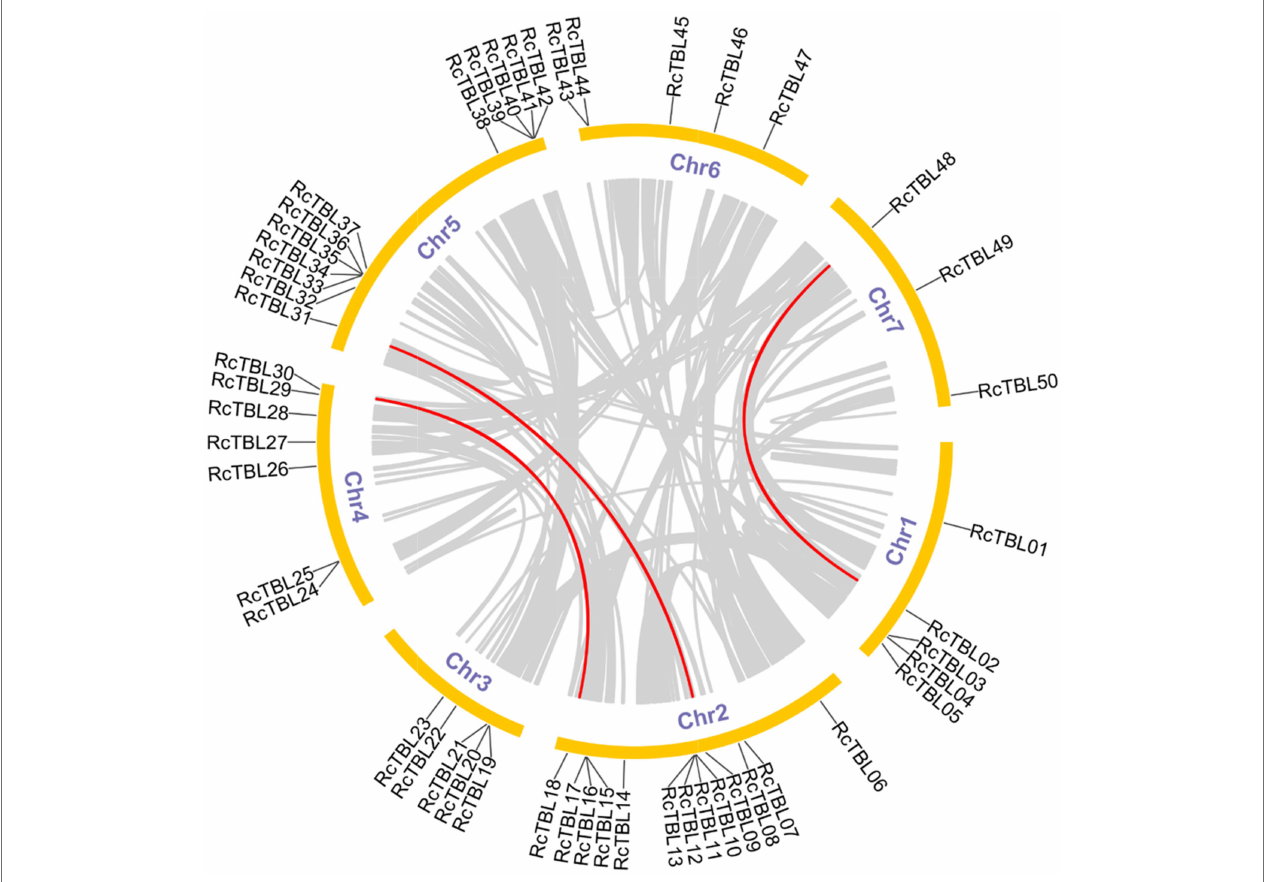
FIGURE 2 | Microsyntenic analyses of the rose TBL protein family members in the R. chinensis genome. Circular visualization of rose TBL protein family members is mapped onto different chromosomes by using Circos. The red lines indicate rose TBL genes with a syntenic relationship. The gray lines represent all syntenic blocks in the genome of R. chinensis.